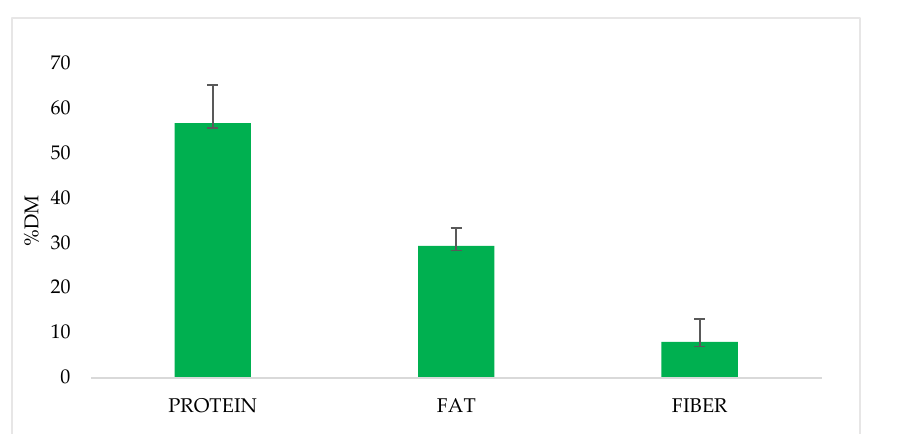
Figure 2. Mean and standard deviation (SD) values of main nutrients content of SP (%DM).